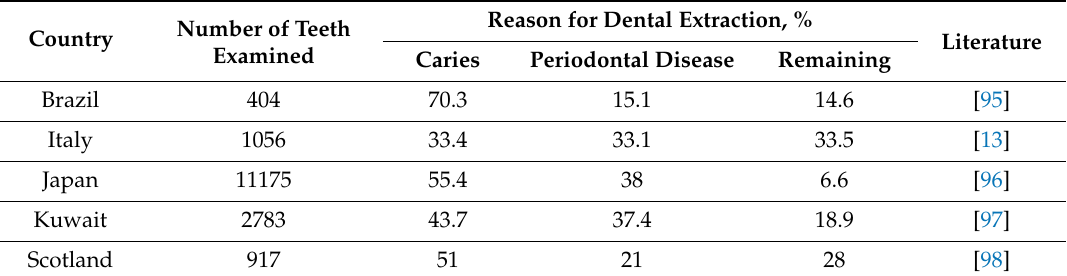
Table 2. Selected epidemiological data on the causes of dental extractions.